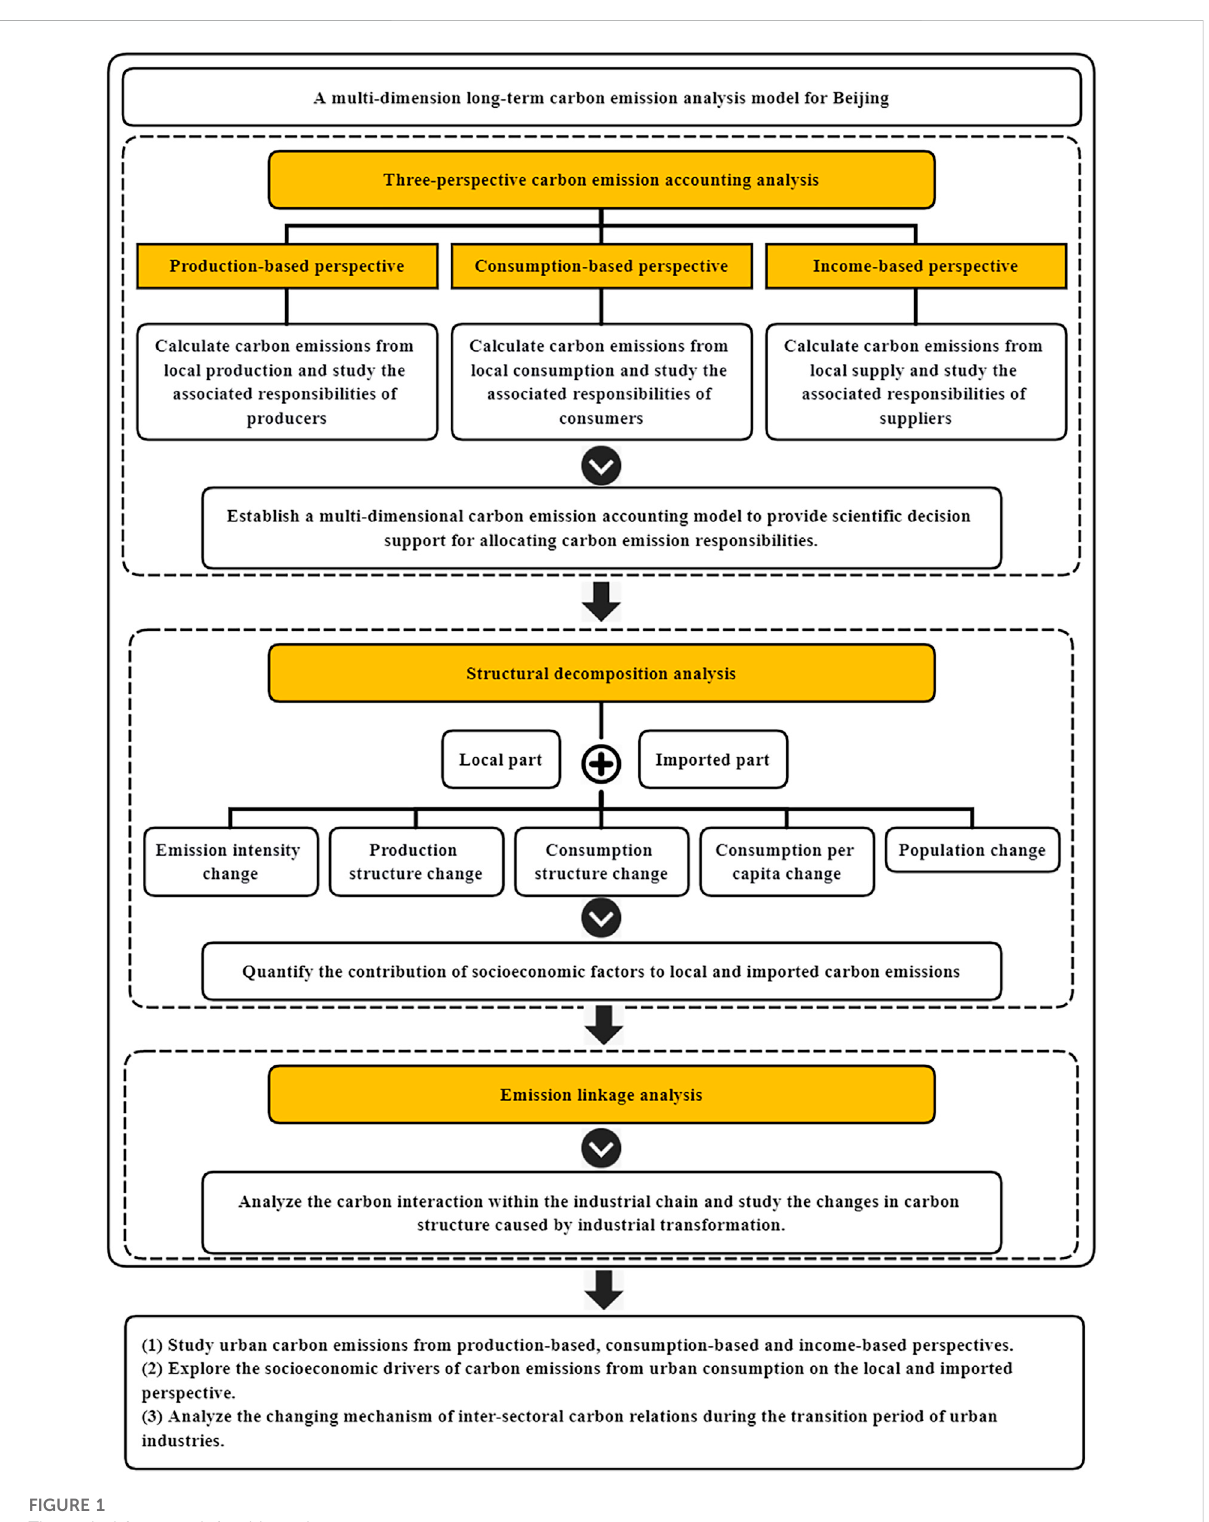
FIGURE 1 Theoretical framework for this